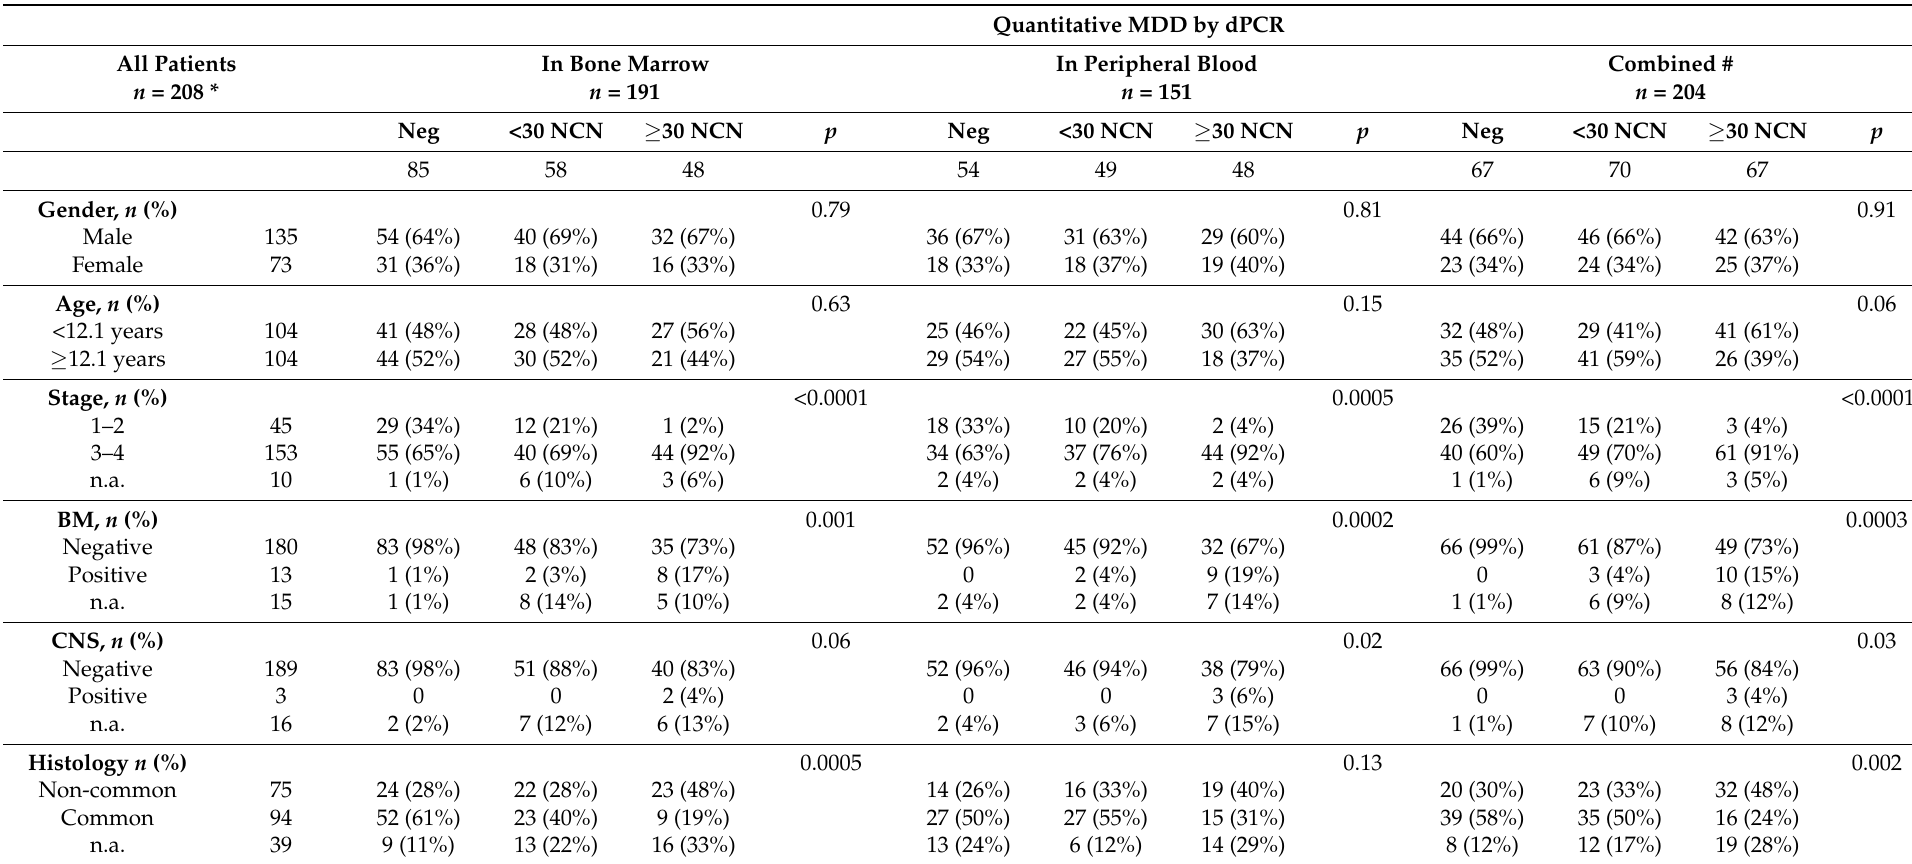
Table 1. Patient characteristics’ of 204 NPM-ALK-positive ALCL-patients according to minimal disseminated disease (MDD). Quantitative MDD by